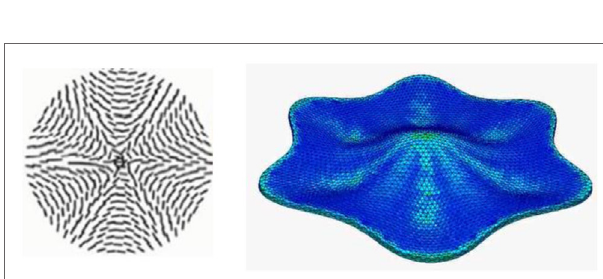
FigUre 3 | left: structure of a − 2 defect . Right: finite element simulation of an LCE disk containing a − 2 defect, shape transformation on heating. Up/ down symmetry is broken by heating from one side, producing a symmetric structure. Color indicates local elastic strain energy.